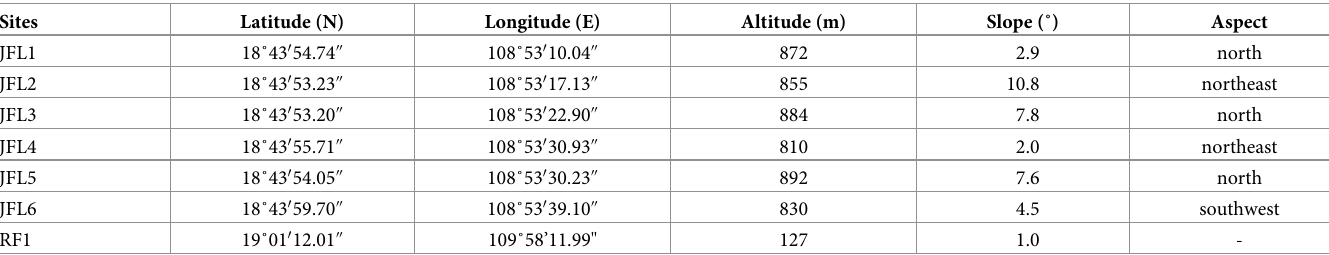
Table 1. Geographical information of soil sampling sites in the tropical rainforest.